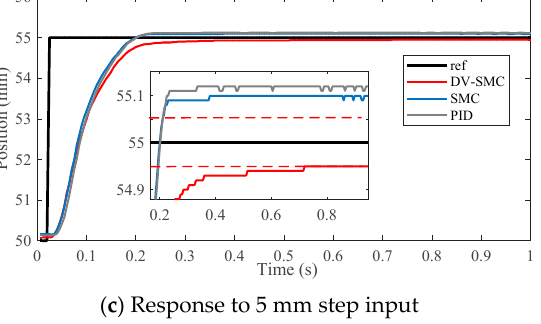
Figure 7. Response to different reference input.